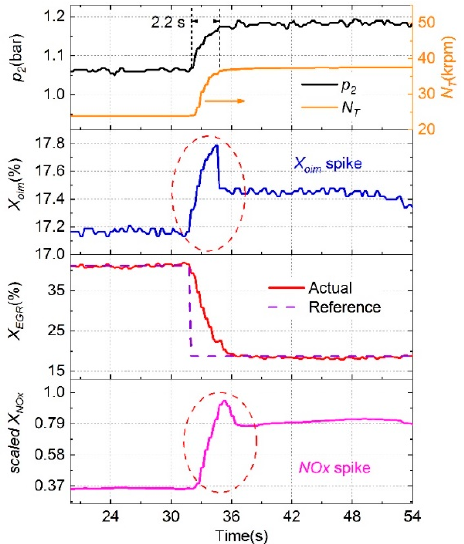
Figure 10. Tip-in test for the nominal system without assist.